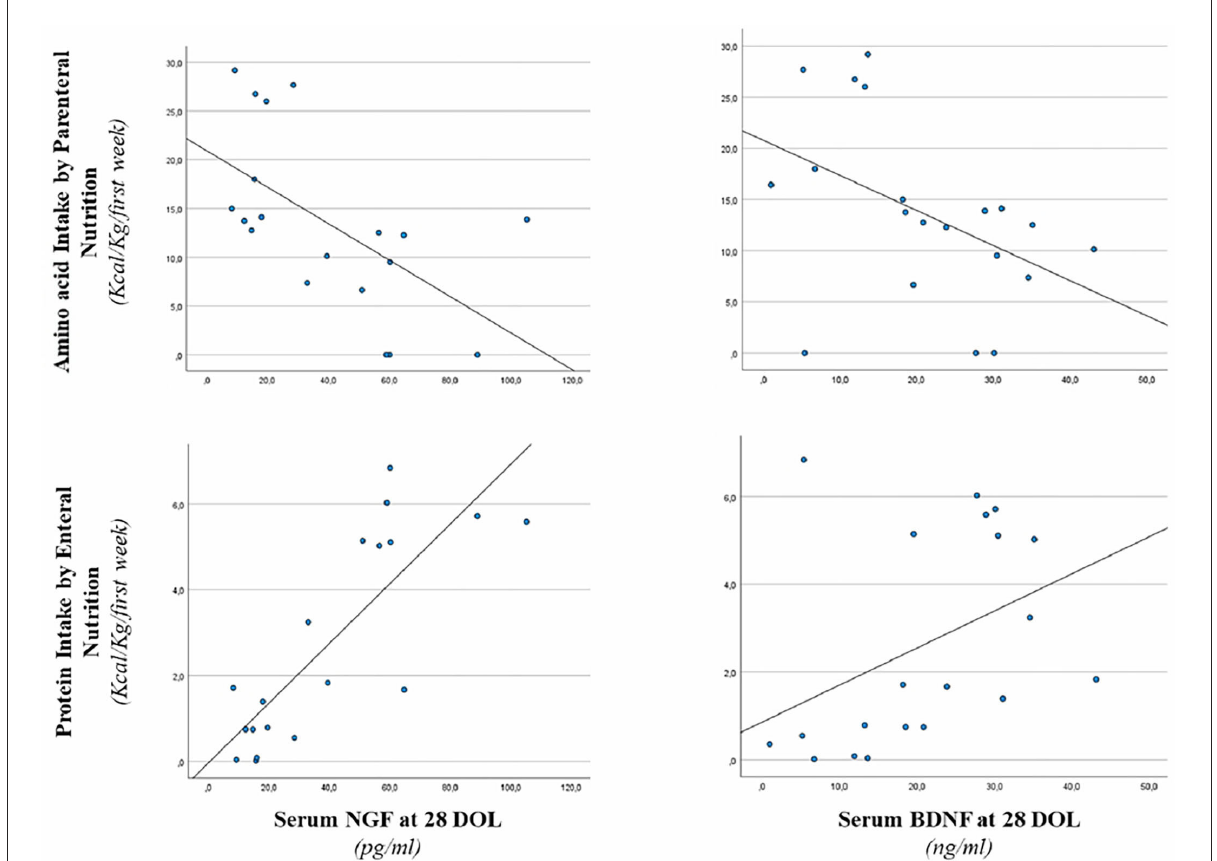
FIGURE3 Correlation between serum NGF and BDNF level at 28 days of life, enteral protein intake, and parenteral amino acid intake. Enteral nutrition: serum NGF ( r = 0.767, p < 0.001) and serum BDNF ( r = 0.544, p < 0.05). Parenteral nutrition: serum NGF ( r = − 0.652, p < 0.001) and serum BDNF ( r = − 0.529, p <